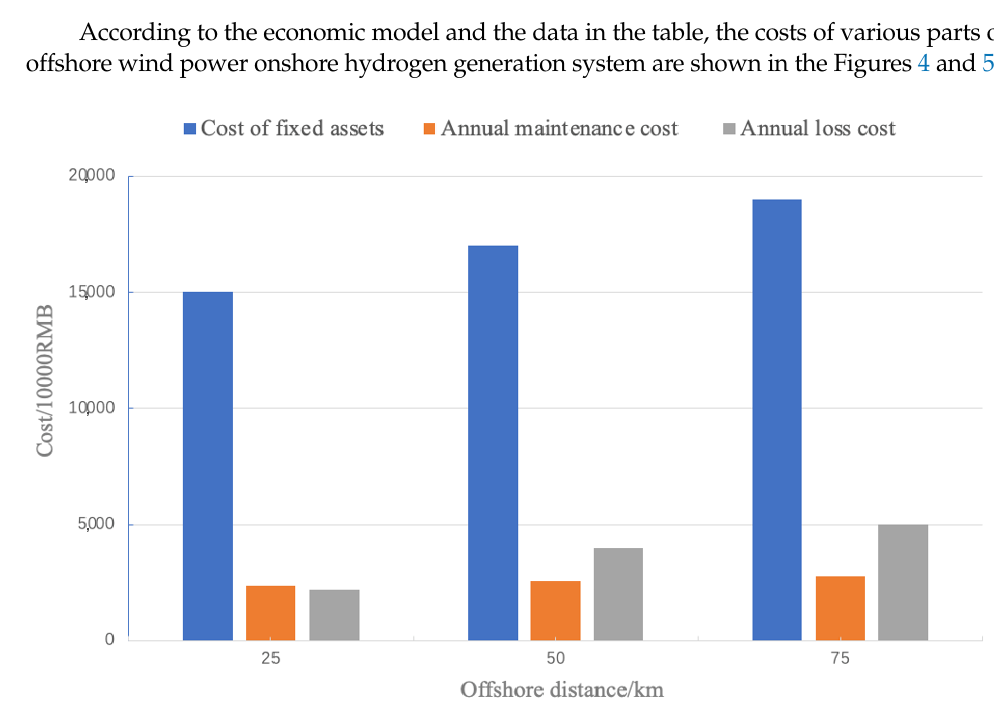
Figure 5. Cost composition of onshore hydrogen production from offshore wind power via DC transmission. It can be seen that the system cost is mainly concentrated in the cost of fixed assets, while the maintenance cost and loss cost account for a relatively small proportion. With the increase of offshore distance, the total cost of both systems increases, and the fixed asset cost and annual loss cost of AC transmission system increase the most. The cost of fixed assets in DC transmission system is large, and the loss of AC submarine cable trans- mission system is larger than that of DC transmission system. Scheme II: Technical scheme for offshore platform hydrogen production and ship/pipeline hydrogen transportation